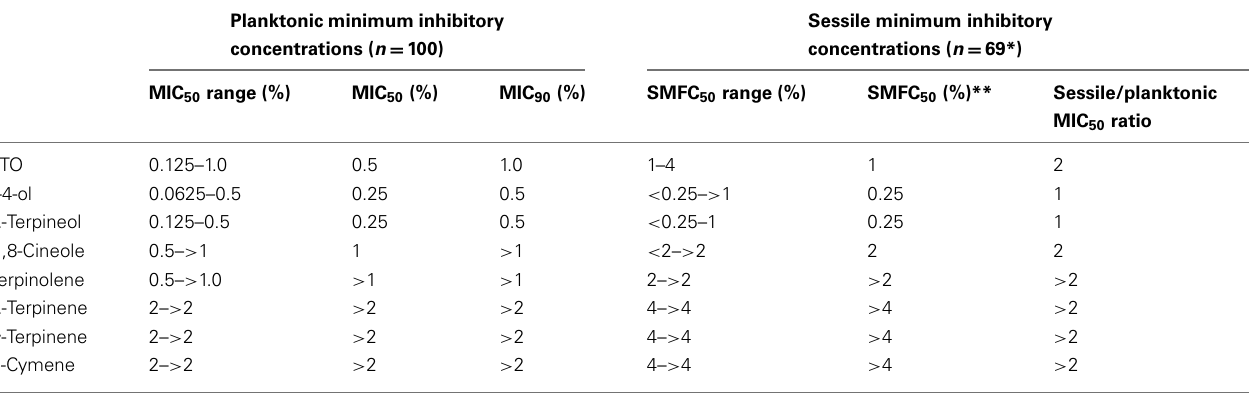
Table 1 | Susceptibility profile of Candida albicans to tea tree oil and derivative components.